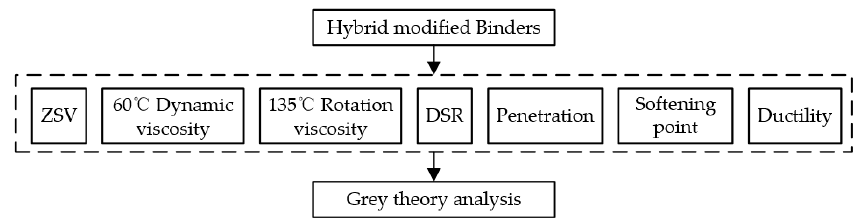
Figure 2. Test route of the properties of Hybrid modified binders.